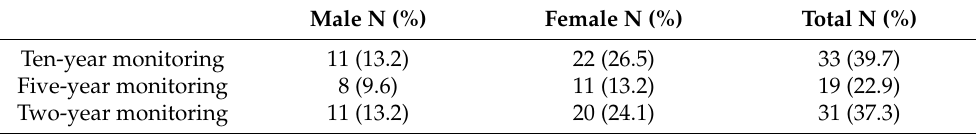
Table 1. Distribution of patients according to the time period of the follow-up visit.